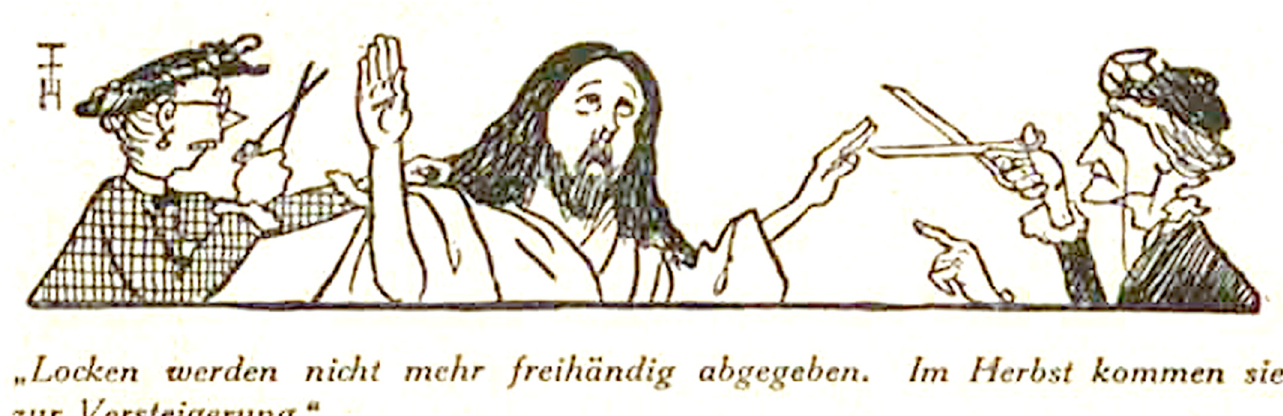
Figure 1. Simplicissimus 26, 53: 2.